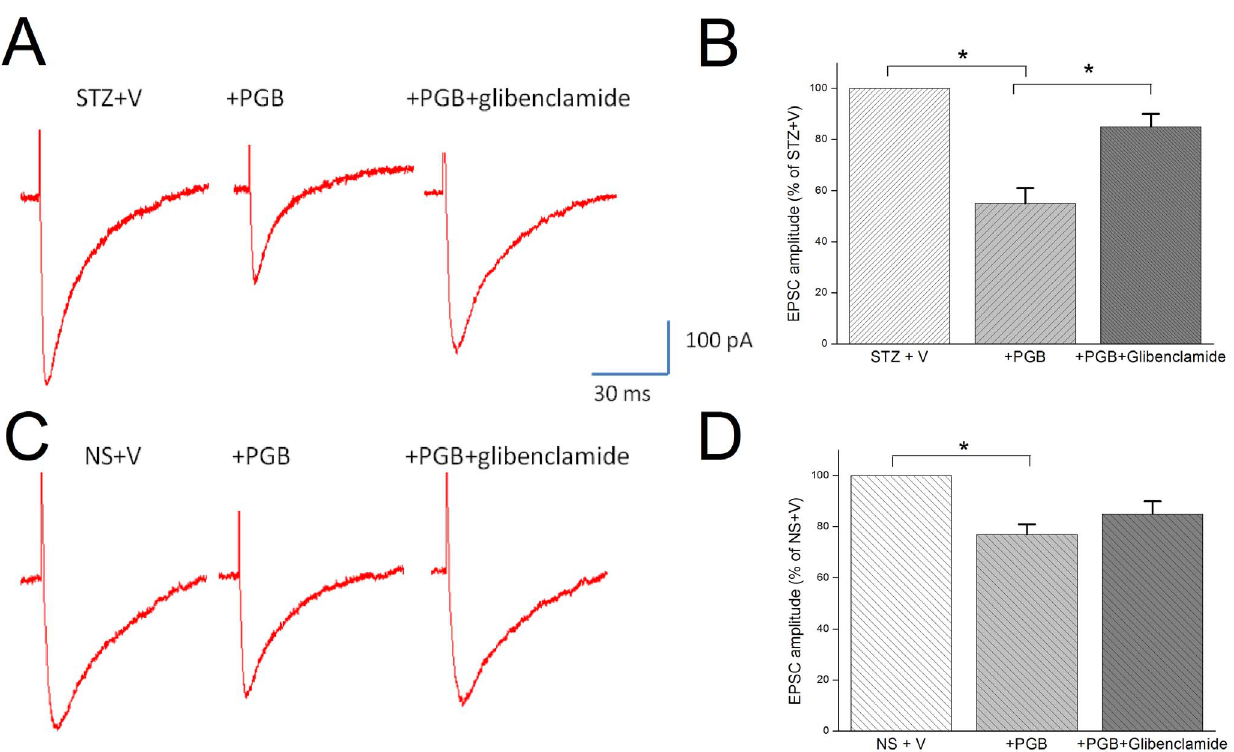
Figure 6. Glibenclamide reversed PGB ’ s effects on the evoked excitatory postsynaptic currents in hippocampal slices. The evoked excitatory postsynaptic synaptic currents (eEPSCs) amplitude in CA1 neurons in the STZ + V and NS + V groups 28 days after status epilepticus. A, B: In the STZ + V group, PGB (25 m M) significantly reduced the eEPSC amplitude (55% 6 6% of baseline amplitude in STZ + V). This reduction was significantly reversed by glibenclamide (10 m M) (85% 6 6% of baseline amplitude in STZ + V). C, D: In contrast, PGB reduced eEPSC amplitude in the NS + V group to a lesser degree (78% 6 4% of baseline amplitude in NS + V); the reduction was non-significantly reversed by glibenclamide (84% 6 5% of baseline amplitude in NS + V) (ANOVA, n=6–7 slices) (* p ,